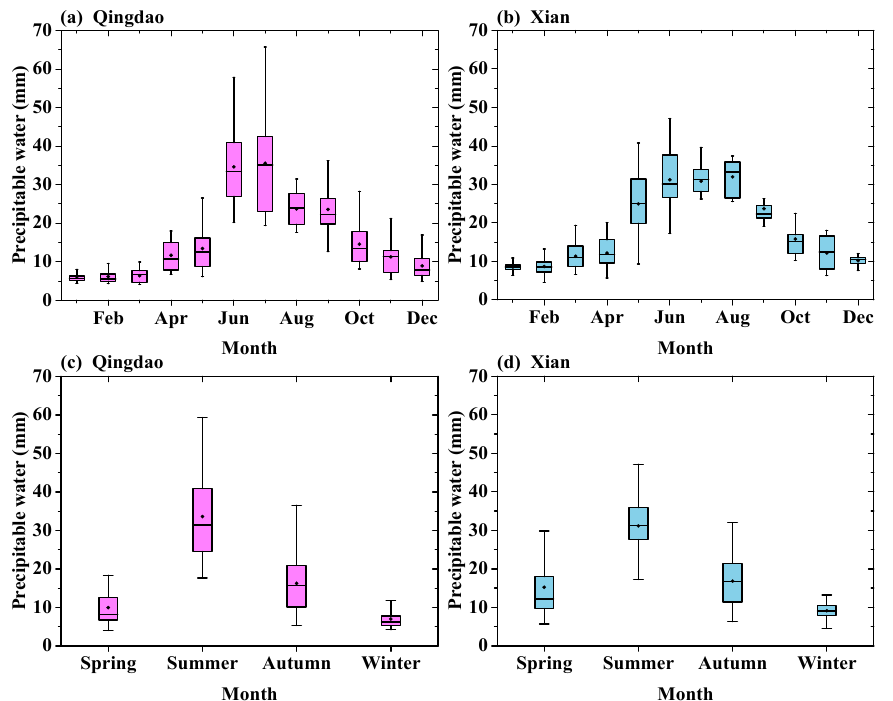
Figure 8. Monthly box of PW: ( a ) Qingdao and ( b ) Xian; seasonal box of PW: ( c ) Qingdao and ( d ) Xian. The central black line on each box indicates the median, the central black circle on each box indicates the mean, and the bottom (top) edge of each box indicates the 25th (75th) percentile. The vertical bars represent the range from the 5th to the 95th percentiles of the